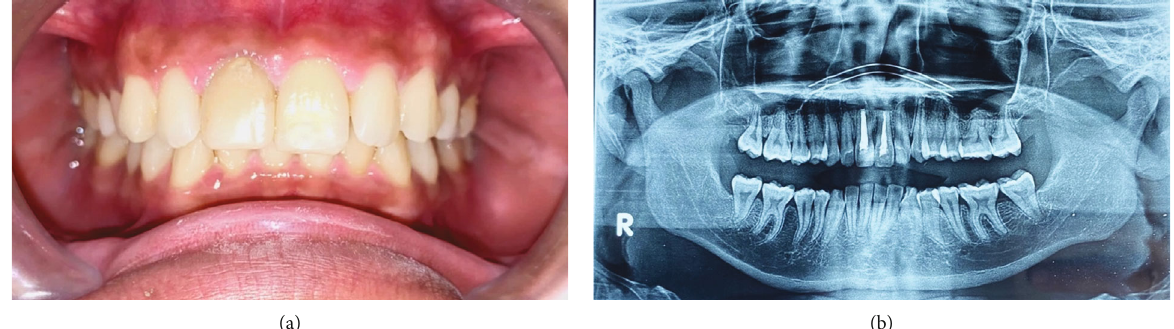
Figure 9: 6 months postoperative recall: (a) intraoral view; (b) radiographic